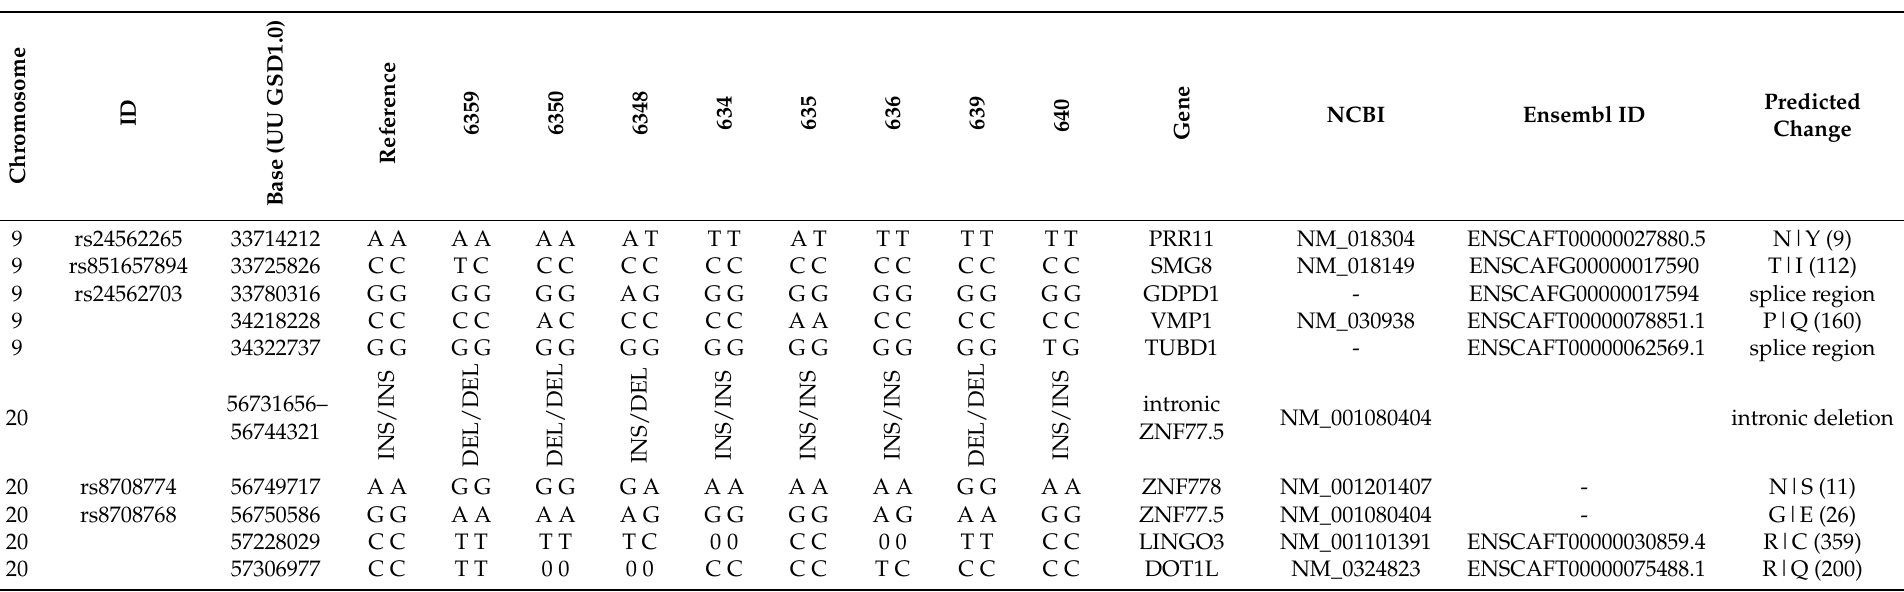
Table 3. Genotypes and predicted outcomes of putatively functional variants in two genomic regions associated with cerebellar abiotrophy in Kelpie